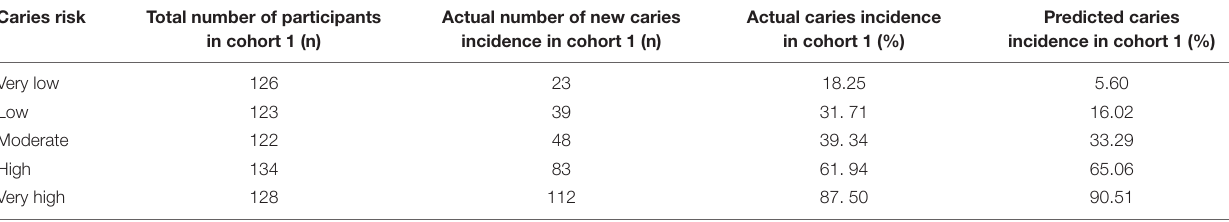
TABLE 5 | Actual number of new caries after 21 months: actual and predicted caries incidences in cohort 2. Caries risk